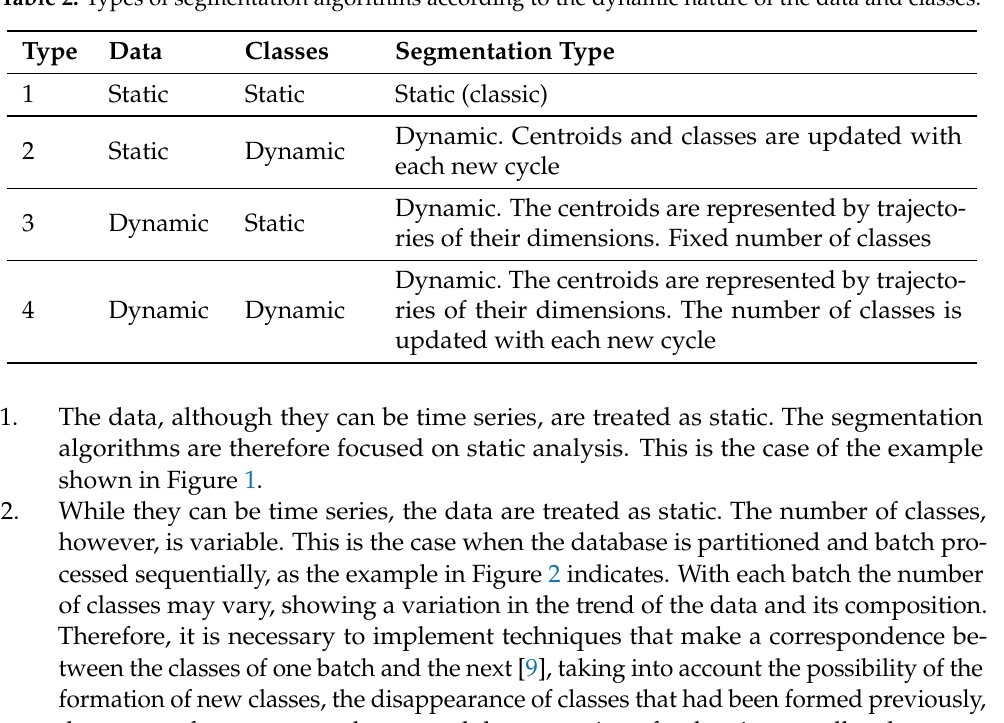
Table 2. Types of segmentation algorithms according to the dynamic nature of the data and